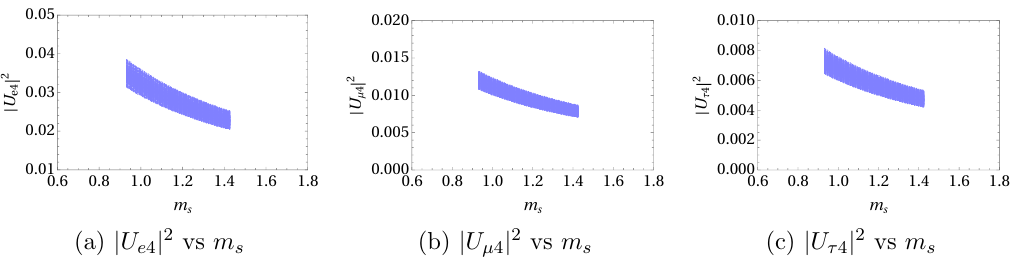
Figure 4 . The active-sterile mixing observables predicted by the model plotted against m s . These curves show the inverse relationship between the moduli-squared values of the active-sterile mixing elements and the sterile neutrino mass as can be inferred from eqs.